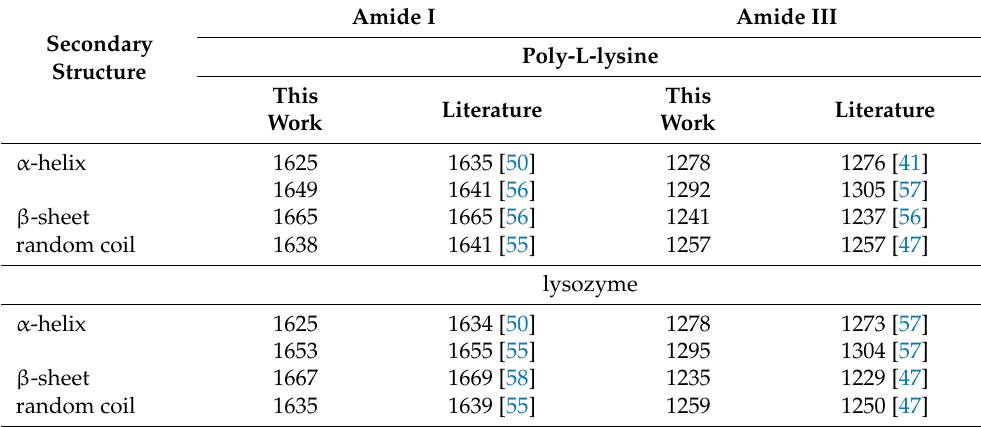
Table 1. Assignments of the secondary structure components to the corresponding Raman peaks and overview of the Raman shifts in cm − 1 of the center peak positions ν s of the Voigt functions in the amide I and amide III bands of the two investigated proteins poly-L-lysine and lysozyme resulting from the spectral reconstruction with an indication of Raman shifts given in the literature (used as starting parameters).